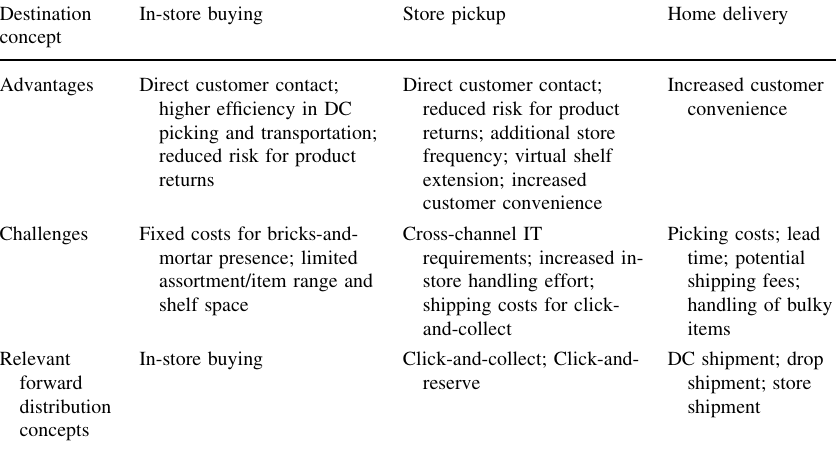
Table 4 Summary of omni-channel destination concepts Destination